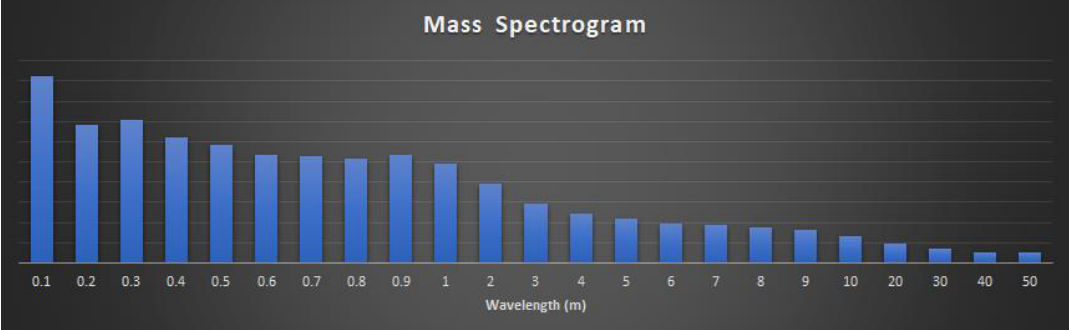
Figure 38. Mass spectrogram.